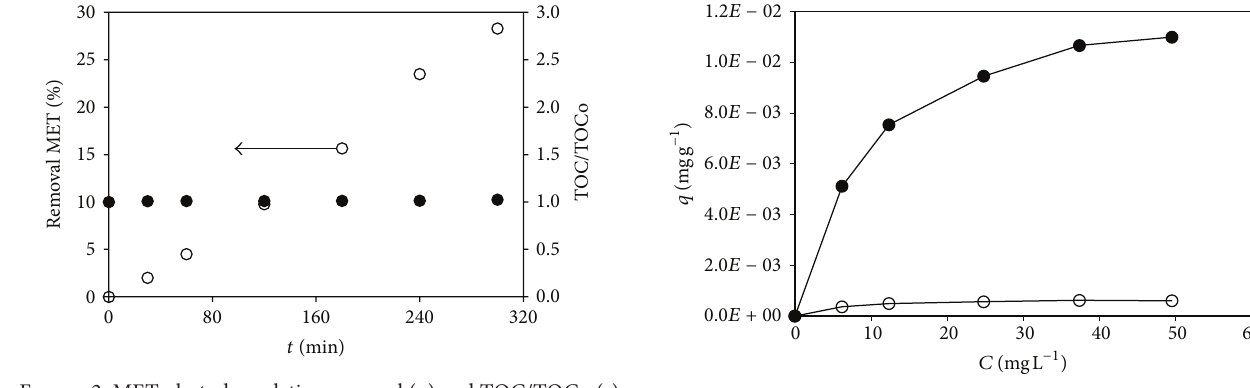
Figure 2: MET photodegradation removal ( I ) and TOC/TOCo ( ∙ ) under simulated UV.